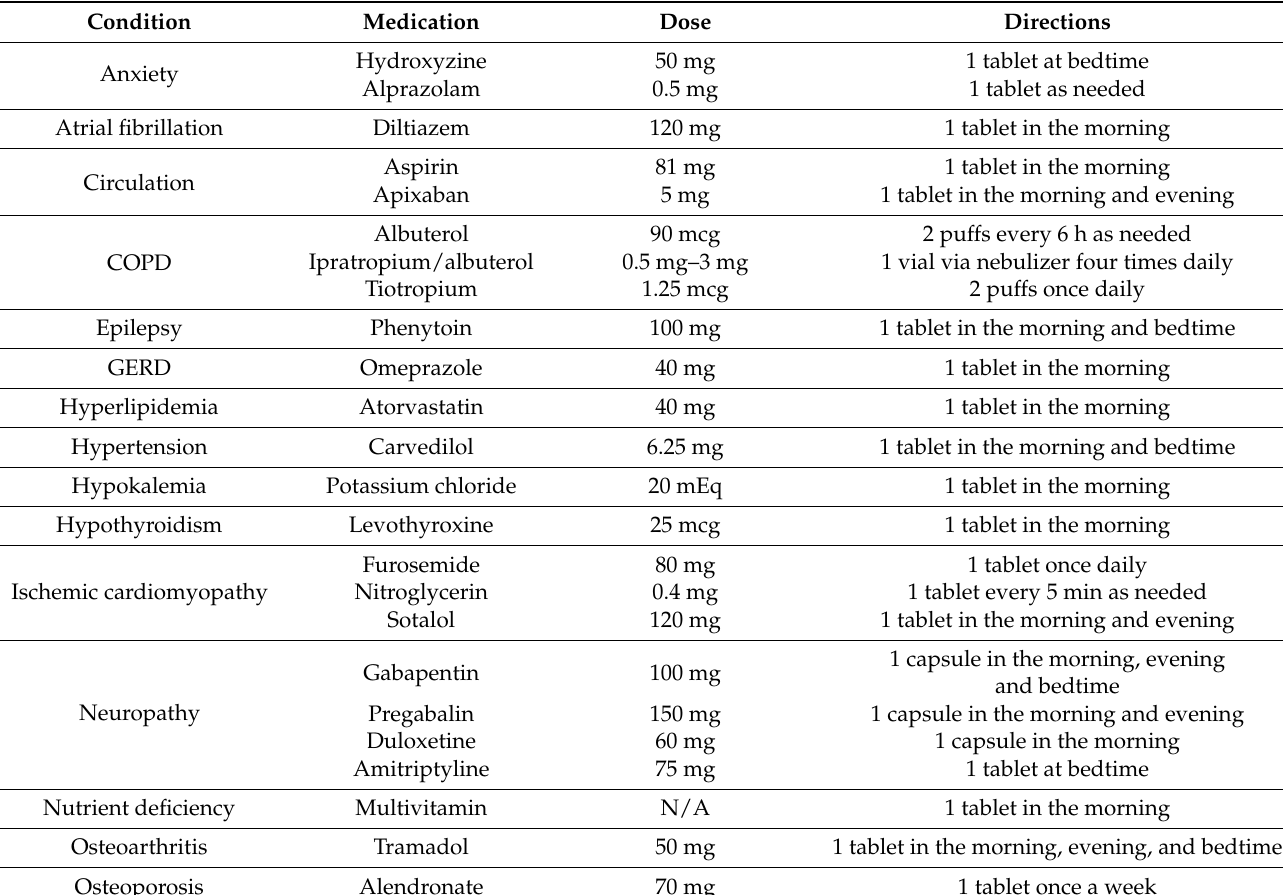
Table 1. Patient’s medication list at the time of PGx testing.